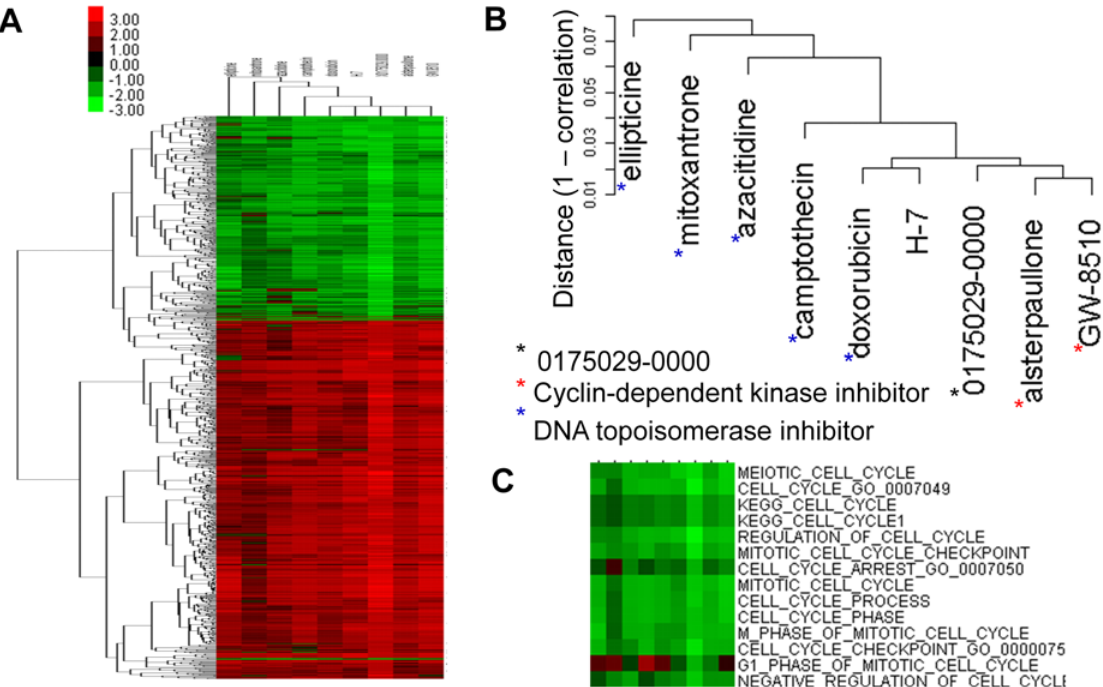
Fig 7. GSLHC identifies 0175029 – 0000 as a novel cyclin-dependent kinase inhibitor (CDKi). (A) A correlation > 0.9 sub-heatmap including the compound 0175029 – 0000 of unknown function from a GSLHC-generated heatmap based on the ES of 1080 tags significantly enriched in 0175029 – 0000 with permutation p < 0.005. (B) Detail of the drug cluster associated with the sub-heatmap. According to the TTD database, GW-8510, alsterpaullone, and H-7 (red asterisk) CDK inhibitors, and doxorubicin, camptothecin, azacitidine, mitoxantrone, and ellipticine (blue asterisk) are DNA topoisomerase inhibitors. All have anti-tumor activities. (C) Detail of the tag cluster with the sub-heatmap shows functions known to be related to the inhibition activities of cell